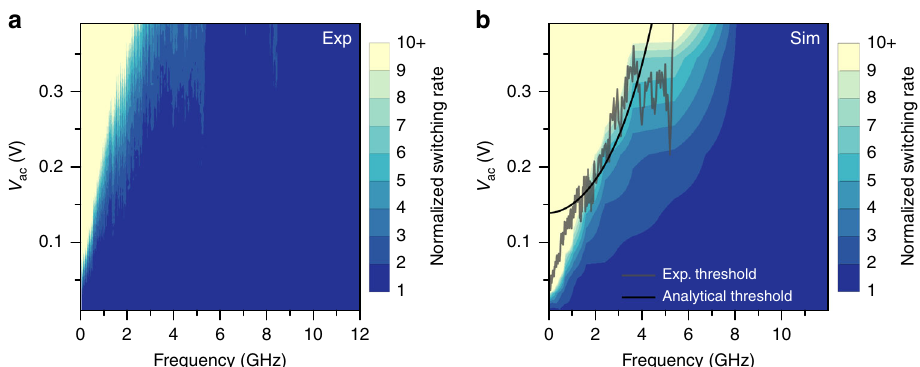
Fig. 4 Room temperature free layer switching rate. The rate is mapped as a function of the applied ac voltage V ac and frequency f for a experiment and b numerical solution of the stochastic LL equation (Eq. (1)). The black line overlayed on ( b ) is analytical prediction of the threshold voltage for the onset of zero-temperature chaotic dynamics due to heteroclinic tangle, while the gray line is experimentally measured threshold voltage obtained from the experimental data in ( a